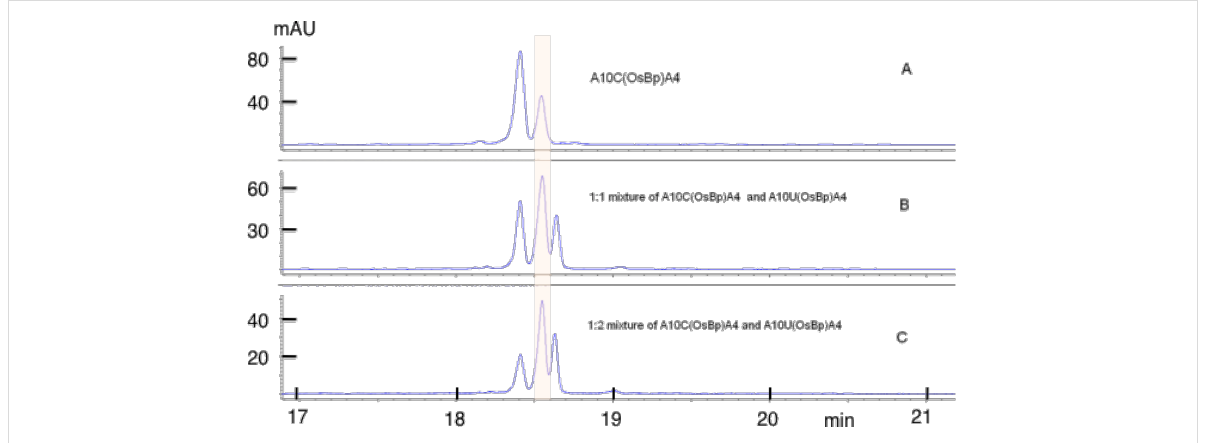
Figure 11: CE profiles: (a) the two peaks corresponding to the two topoisomers of A 10 C(OsBp)A 4 (C-oligo) by top or bottom addition of OsBp to the pyrimidine ring; CE profile of A 10 U(OsBp)A 4 (U-oligo) is comparable. (b) shows that a mixture of the two materials does not completely resolve to four peaks, but only to three peaks, even after using the long capillary (see Experimental). (c) shows that by adding extra U-oligo, the first peak decreases. Hence the U-oligo migrates later compared to the C-oligo. The profiles are shown in different scales to partially correct for the fact that by adding the U-oligo, the C-oligo is diluted. This figure illustrates that degradation of C(OsBp) to U(OsBp) in this oligo would have been detectable as a new peak appearing right after the smaller of the two isomers (see Figure 12 for further evidence).